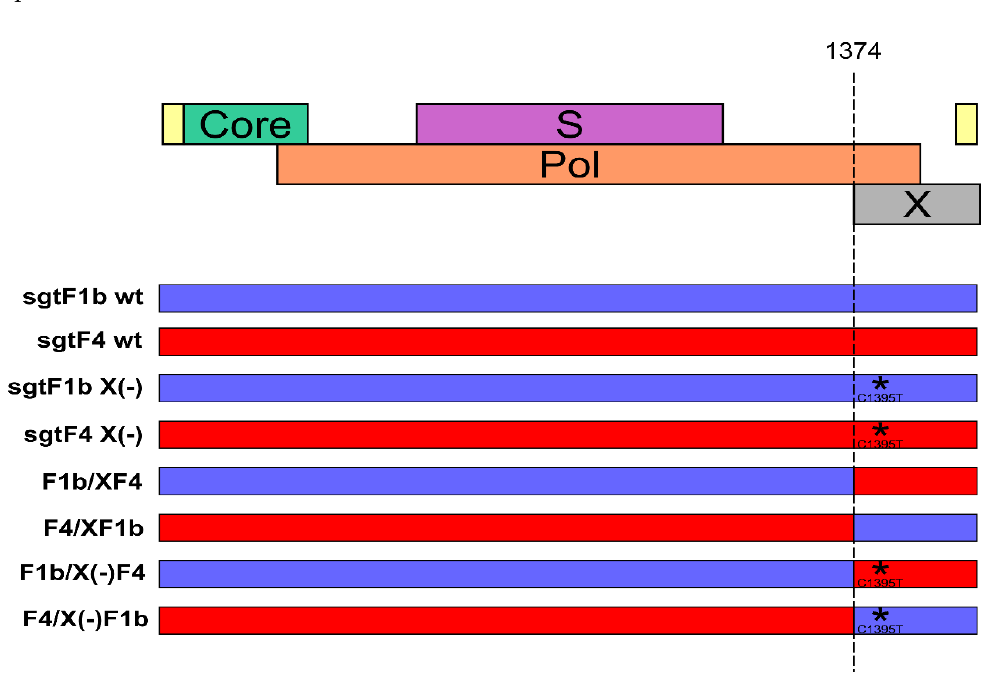
Figure 1. Schematic representation of the Hepatitis B virus (HBV) genomes used in the study. The asterisk represents the introduction of C1395T mutation that abolishes the expression of HBx.